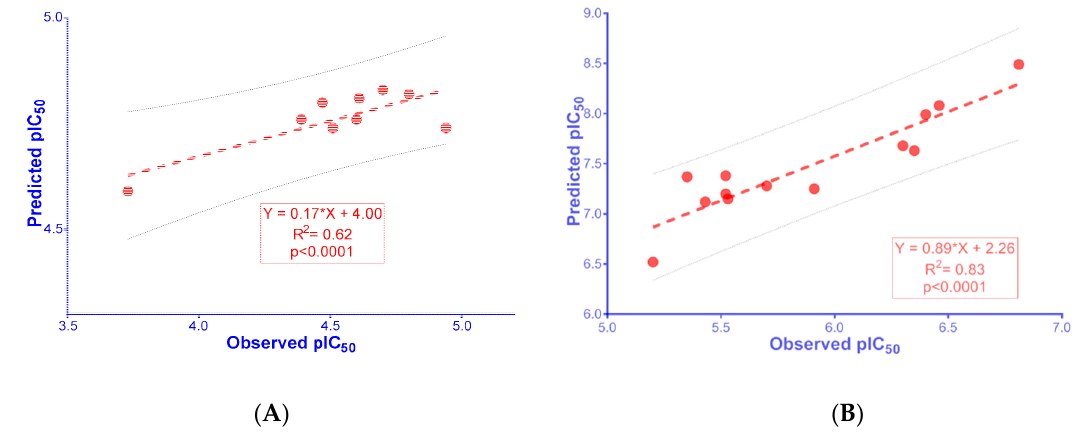
Figure 5 . The linear regression between observed and predicted activities of synthesized chalcone derivatives against ( A ) AChE (values from AC1–3, AC6–11) and ( B ) BACE-1 (values from